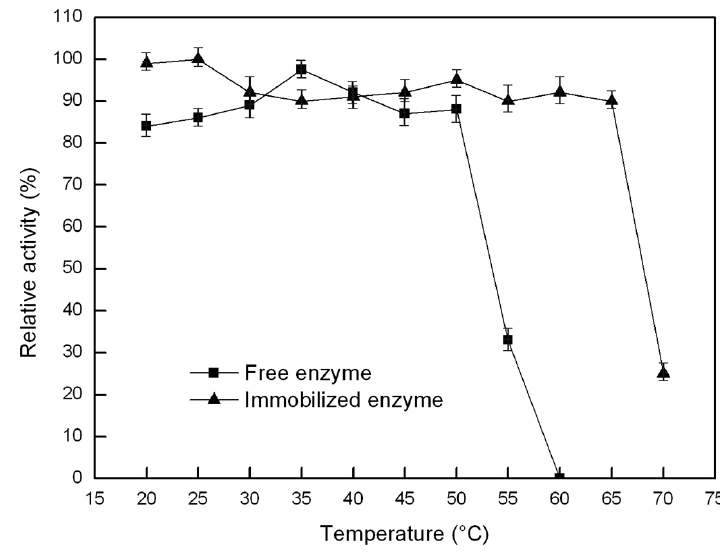
Figure 6. The temperature stability; enzyme activities without treatment were taken as 100%.